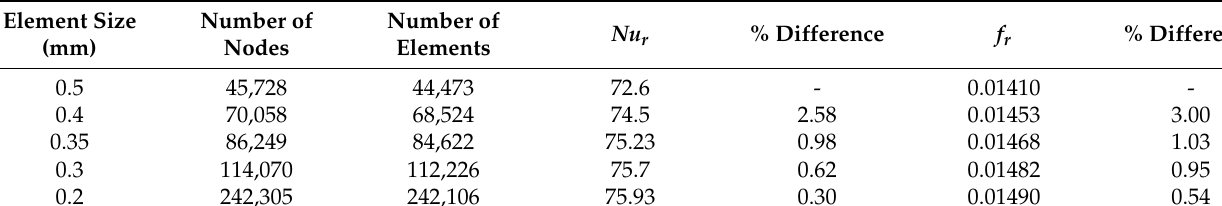
Table 4. Grid independence test.